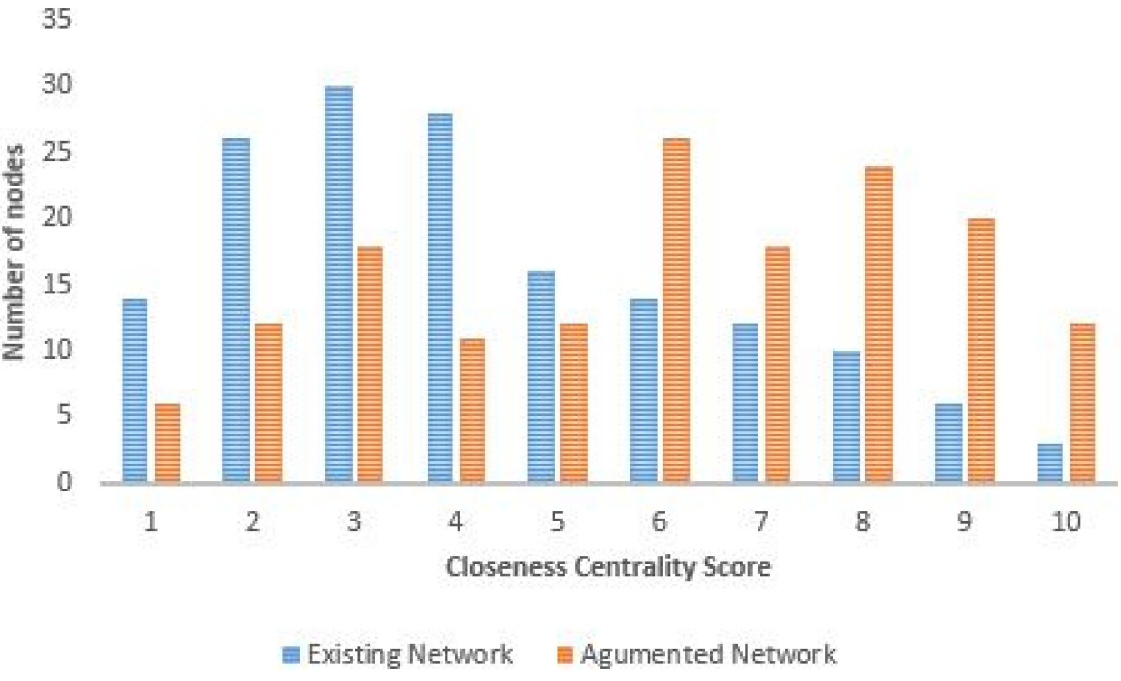
Fig 16. Closeness centrality score: Existing network and augmented network.